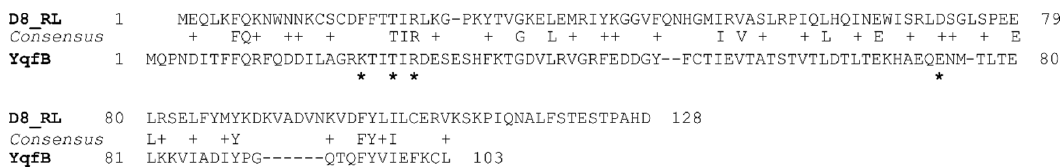
Figure 3. Alignment of tehe D8_RL and YqfB amino acid sequences. The catalytic amino acids of YqfB are marked by asterisks.